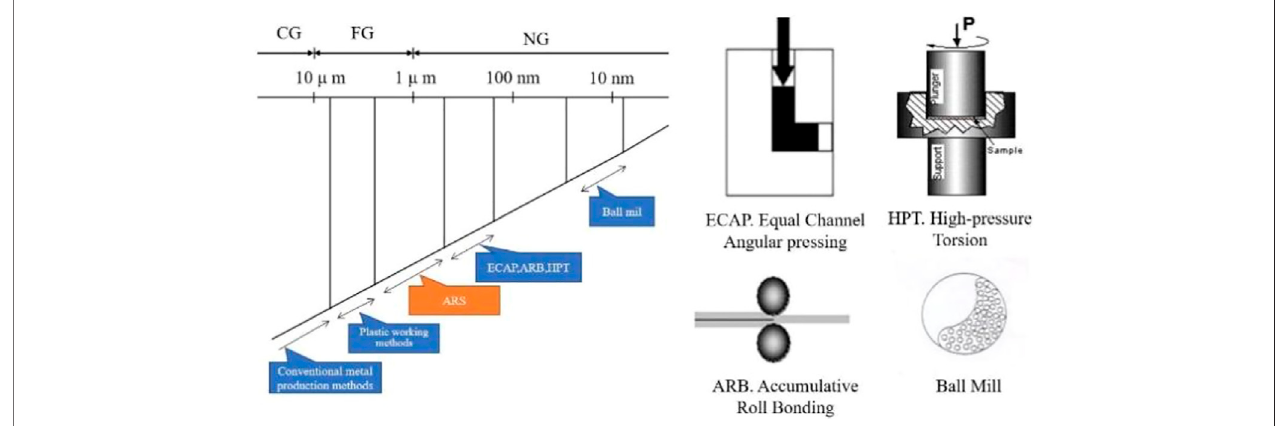
FIGURE1 | Various techniques for production ofUFG materials and the correspondinggrain size levels. Note: CG-Coarse grains; FG-Fine grains; NG-Nano-sized grains.